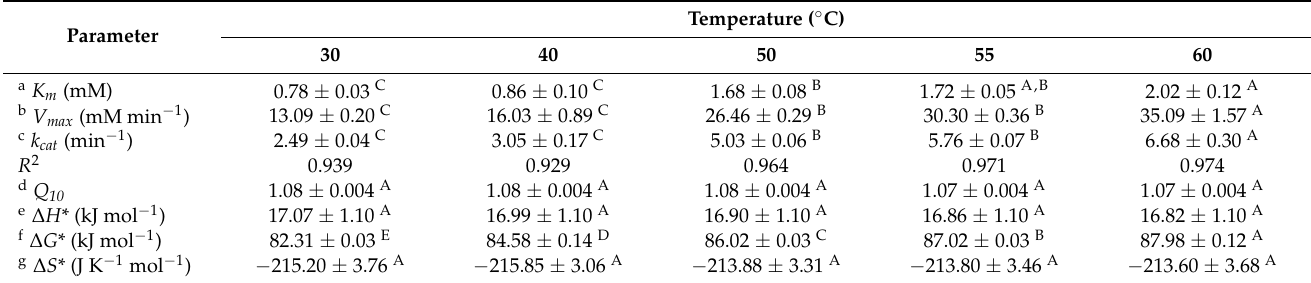
Table 7. Kinetic and thermodynamic parameters of inulin hydrolysis catalyzed by inulinase from Aspergillus terreus URM4658 at different temperatures.